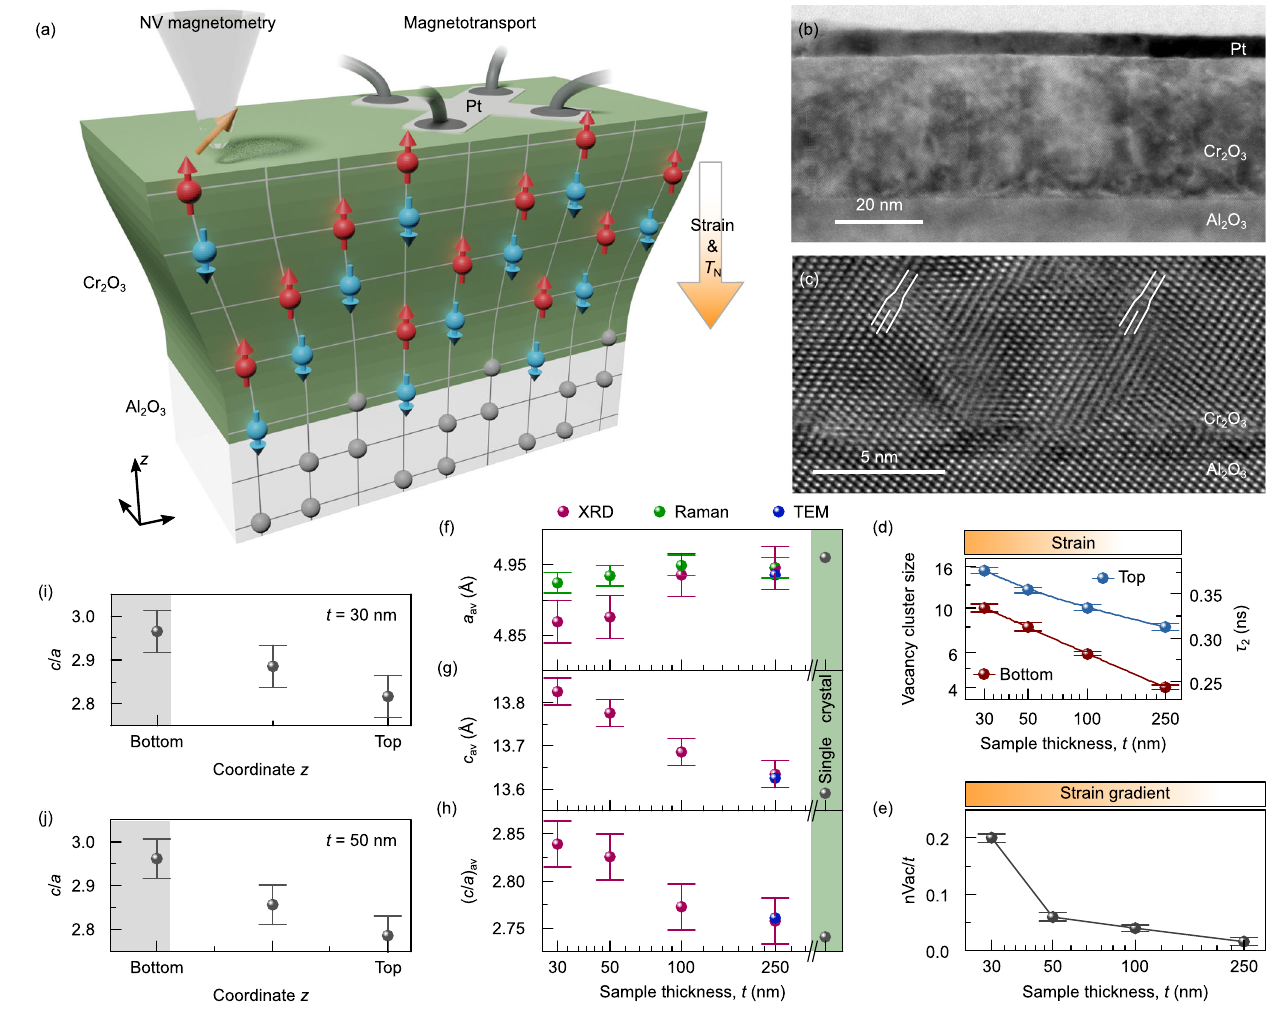
Fig.1|Thin fi lmsofCr 2 O 3 withastraingradient.a SchematicofaCr 2 O 3 thin fi lm prepared on a Al 2 O 3 substrate. The fi lm experiences a strain gradient along its thicknessthatleadstoagradientoftheNéeltemperature.TheNéeltemperatureat thetopsurfaceisprobedviamagnetotransportrelyingonthetransversalspinHall magnetoresistance in a Pt electrode adjacent to the Cr 2 O 3 fi lm. The Néel tem- perature in the interior of the fi lm is probed via NV magnetometry. b Cross- sectional bright- fi eld TEM image showing the Al 2 O 3 /Cr 2 O 3 /Pt stack for a 30-nm- thick sample. The sample does not reveal the presence of grain boundaries (see also Supplementary Note 1). c High-resolution TEM of the Al 2 O 3 /Cr 2 O 3 interface. Twomis fi tdislocationsareindicatedinwhite.Thedislocationsarelocatedabout5 nmawayfromtheAl 2 O 3 /Cr 2 O 3 interface. d Positronlifetimecomponent τ 2 andthe corresponding calculated vacancy cluster size (assuming spherical geometry) in thetopandbottomregionsoftheCr 2 O 3 fi lmsofdifferentthickness t .Thevacancy cluster size increases for thinner samples, indicating larger strain. Error bars